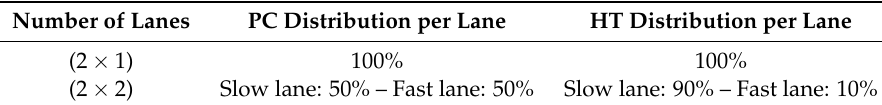
Table 4. Vehicle distribution per